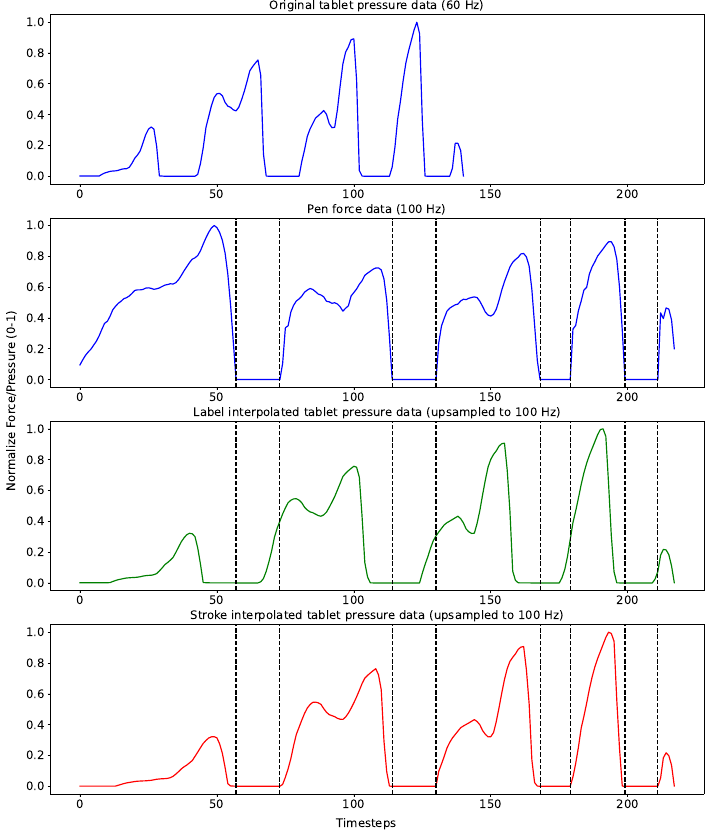
Figure 4. Tablet data upsampling via complete label interpolation and stroke-based interpolation. The tablet recorded the absolute position of the pen tip on the screen at each timestep. However, since the aim of the system was to retrace the tip of the pen between a start and end position on a surface, the absolute positions in the data were converted into relative displacement vectors. This allowed the system to learn the displacement of the pen tip from its original location after movements of the pen, instead of the absolute coordinates. To this end, the difference between the data points among each sample was calculated, adding a zero in the first position to keep the same length of each sample. Additionally, this served as an alternative to data scaling since the absolute values of the data, on a high resolution scale, were reduced to the relative differences between the timesteps. Figure 5 shows an example of the character ’B’ in the absolute trajectory and the calculated relative displacement vectors. Sensor data was normalized using the Z-score normalization and used in the normalized raw form as